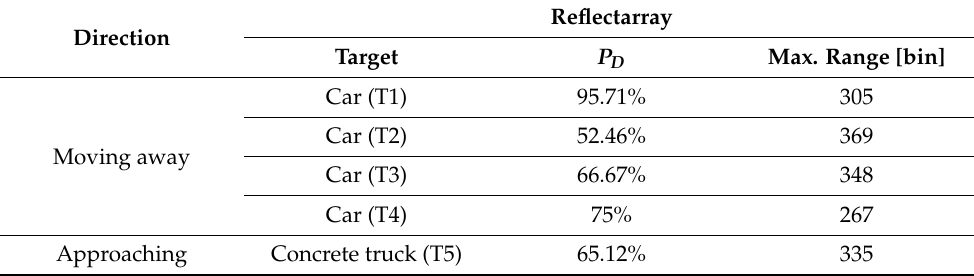
Figure 17. Video ground truth of an instant of the measurement in scenario 2, its corresponding RD map and the cumulative of RD maxima. Table 3. Probability of detection of targets in scenario 2 employing the designed reflectarray as surveillance antenna. T1–T5 refers to the tracks represented in Figure